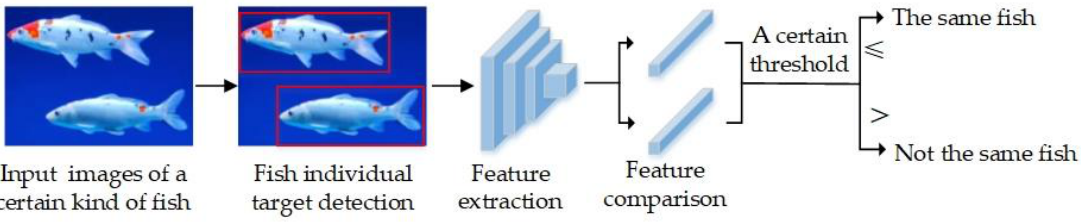
Figure 1. Flow chart of fish individual recognition.